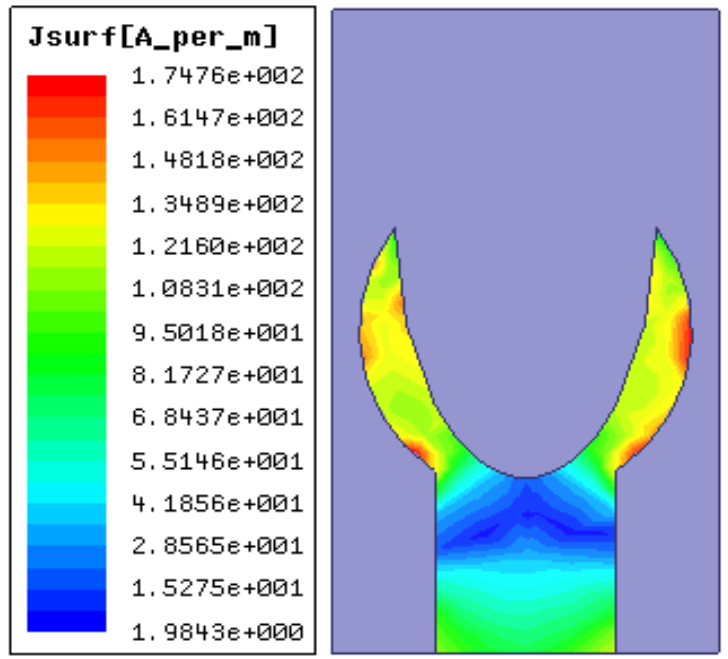
Figure 8. The designed antenna’s current distribution at 28 GHz.